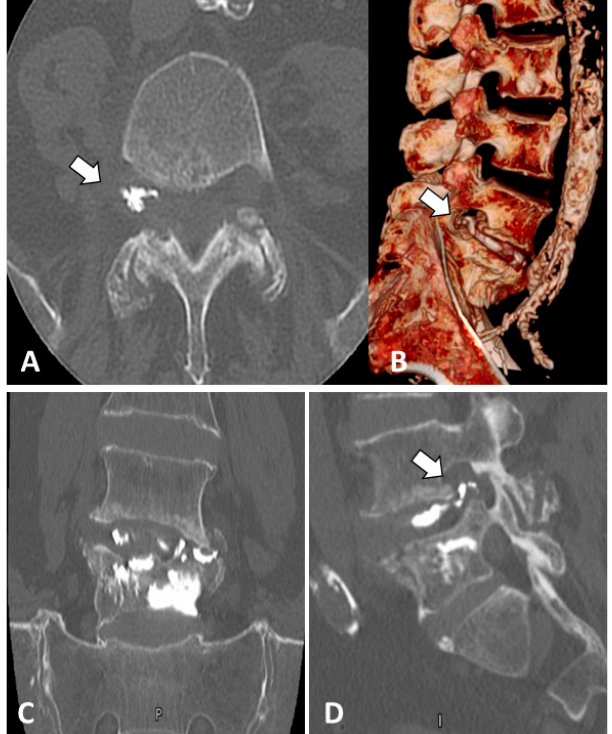
Figure 2. ( A ) Axial CT scan at the fracture level, documenting cement leakage in the neuroforamen (white arrow); ( B ) A 3D CT reconstruction of the lumbar spine: cement extravasation visible in the right neuroforamen (white arrow); ( C ) sagittal CT scan of the L5 fracture after VP; ( D ) sagittal CT scan at the fracture level, documenting cement leakage in the neuroforamen (white arrow).